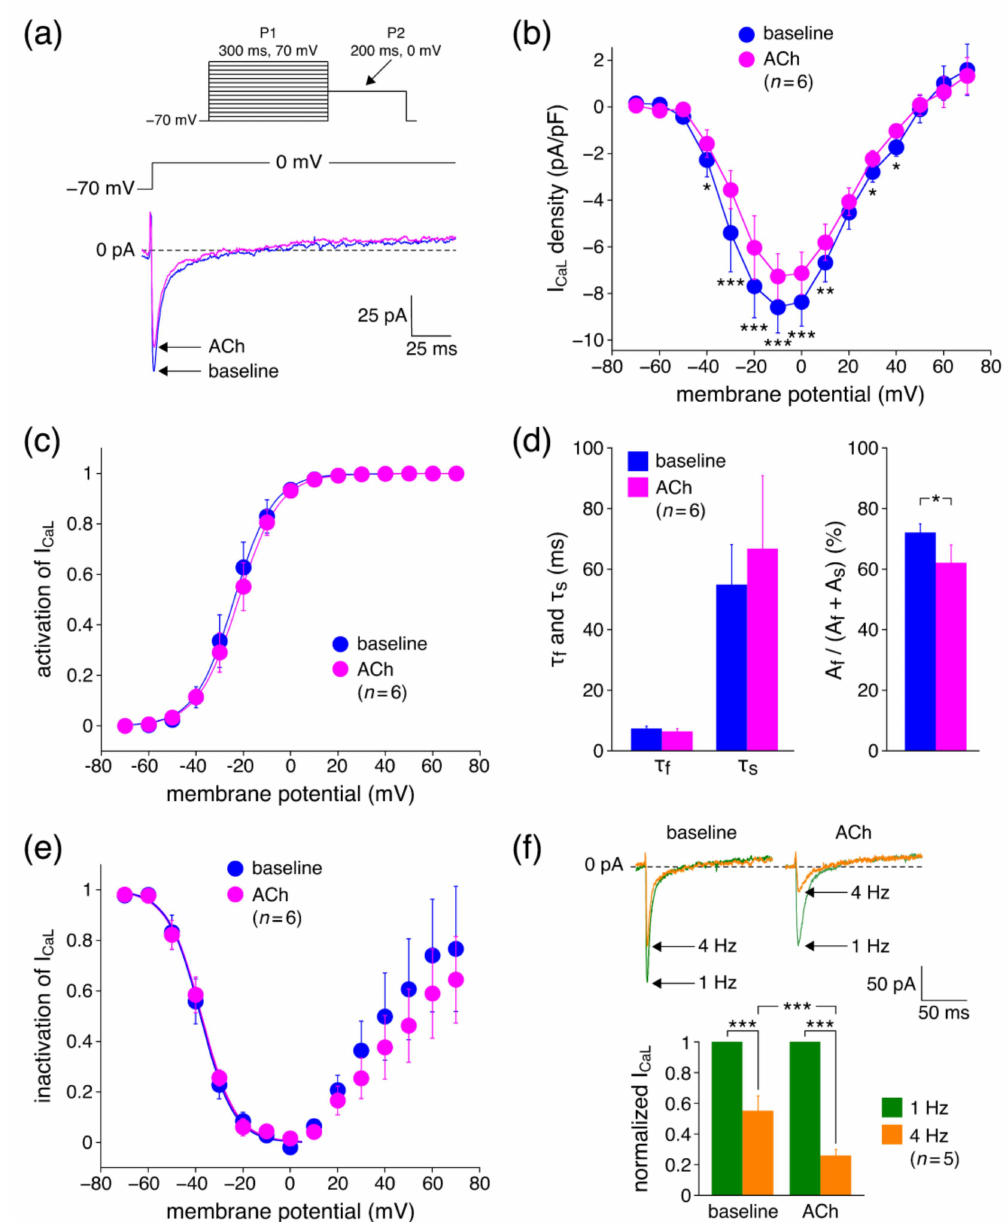
Figure 3. Effects of ACh on L-type Ca 2+ current (I CaL ) in human induced pluripotent stem cell derived cardiomyocytes (hiPSC-CMs). ( a ) Typical example of I CaL in absence (baseline) and presence of ACh (blue and magenta traces, respectively). Inset: double pulse protocol used to measure I CaL . ( b ) Average current–voltage relationship of I CaL ( n = 6). * p < 0.05; ** p < 0.01; *** p < 0.001 (two-way repeated measures ANOVA). ( c ) Voltage dependence of activation of I CaL ( n = 6). ( d ) Rate of I CaL inactivation in response to depolarizing pulses from − 70 to 0 mV (with fast and slow time constants τ f and τ s , respectively; left) and relative amplitude of its fast and slow components (right) ( n = 6). * p < 0.05 (paired t -test). ( e ) Voltage dependence of inactivation of I CaL ( n = 6). ( f ) I CaL measured at 1 and 4 Hz in response to 200 ms depolarizing pulses from − 70 to 0 mV ( n = 5). *** p < 0.001 (two-way repeated measures